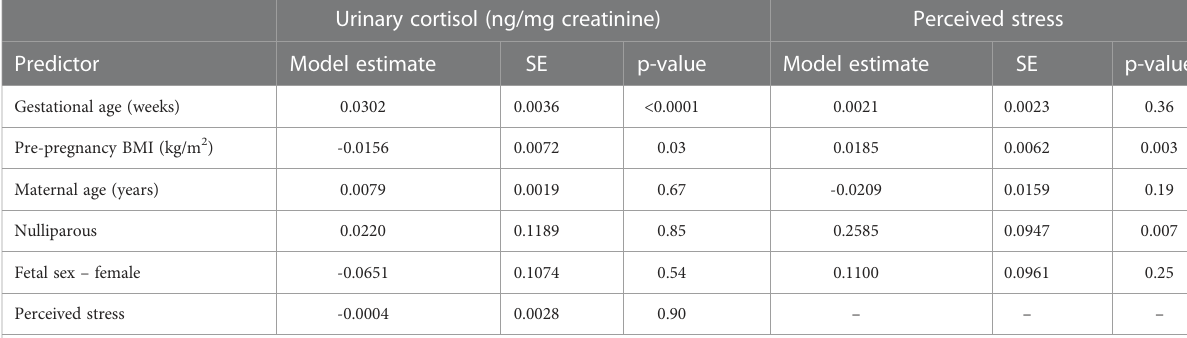
TABLE 2 Predictors of maternal urinary cortisol (ng/mg creatinine) and perceived